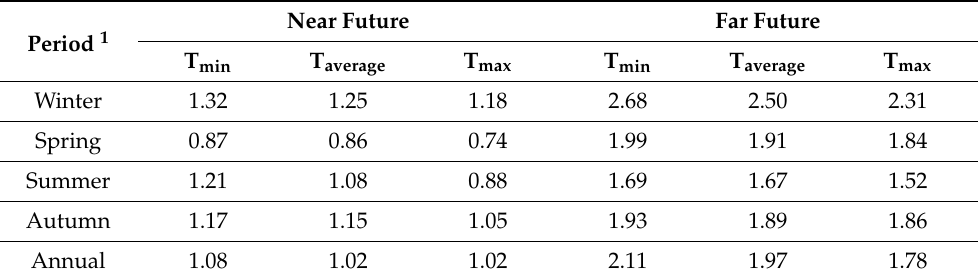
Table 3. Projection of average, minimum and maximum temperature ( ◦ C) increase for near future (2021 to 2050) and far future (2071 to 2100) compared to the historical period (1971 to 2000). Near Future Period 1